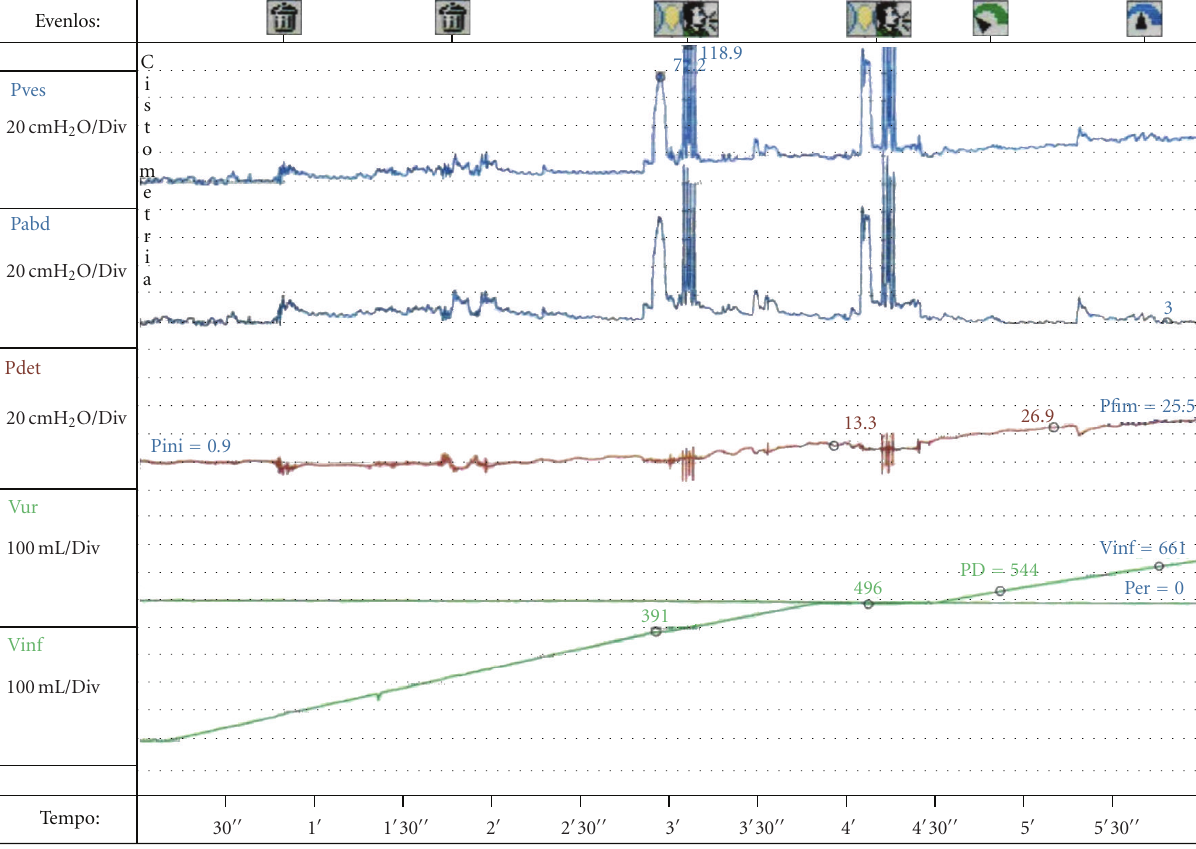
Figure 2: Urodynamic study performed on patient (2010) displaying detrusor arreflexia. Pves: vesicular pressure, Pabd: abdominal pressure, Pdet: detrusor pressure, Vur: urine volume, Vinf: infusion